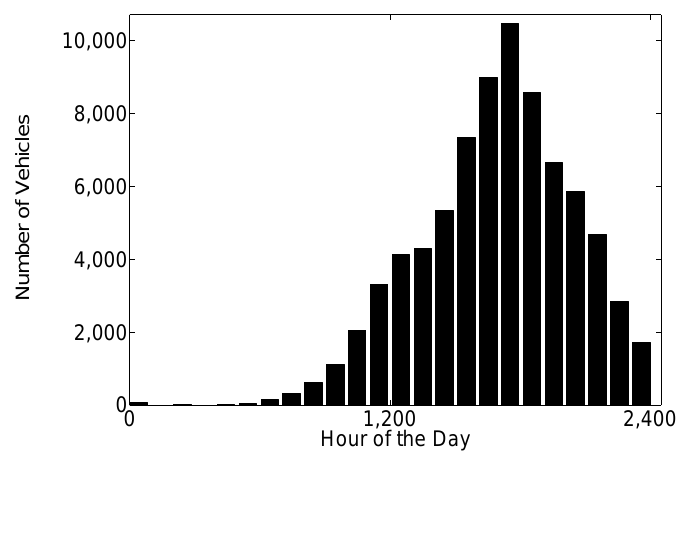
Figure 3. Number of vehicles returning per hour.